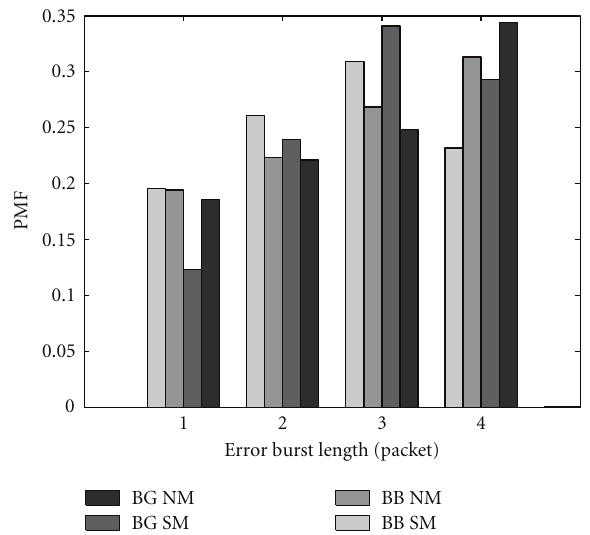
Figure 14: Zoom on the distributions of Figure 13 in the x-range of 1–5 packets with FEC (10,5) and interleaver depth of 32 (SM) and 224 (NM) packets,